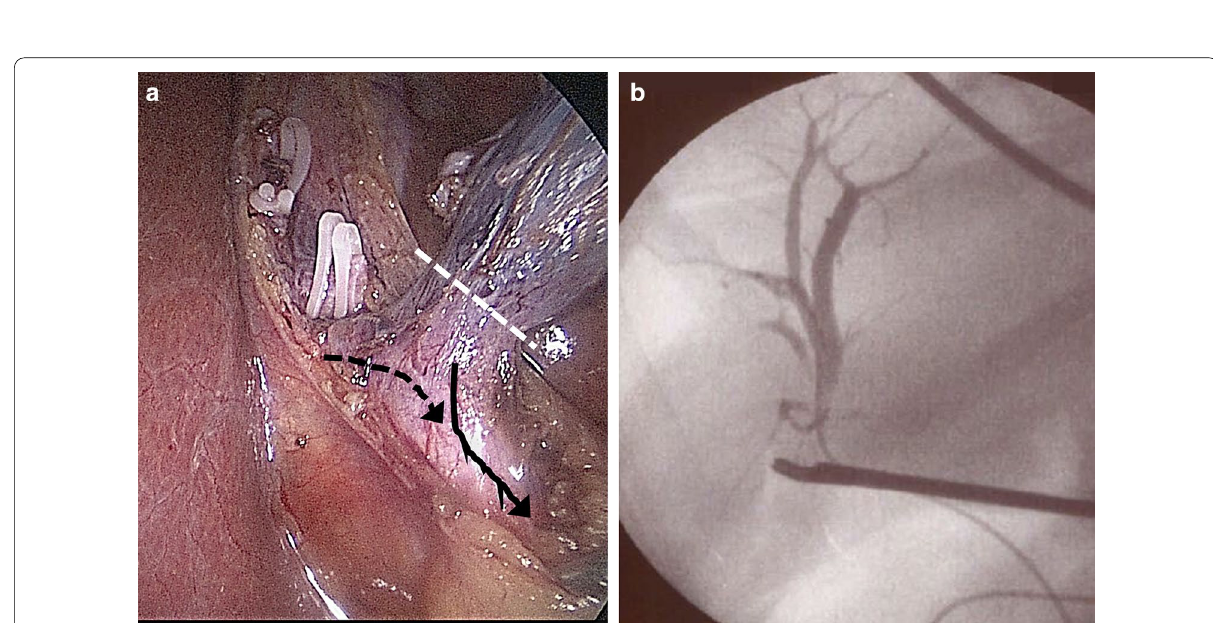
Fig. 2 Intraoperative findings of laparoscopic cholecystectomy. a An image showing the confluence of the right hepatic duct on the cystic duct. The white dotted line indicates the cut line of the gall bladder for subtotal cholecystectomy. The black arrow indicates the cystic duct. The black dotted arrow indicates the right hepatic duct entering the cystic duct. b Intraoperative cholangiography using an ENBD catheter confirming that the forceps grasping the intended cut line of the gallbladder was distant from the ENBD